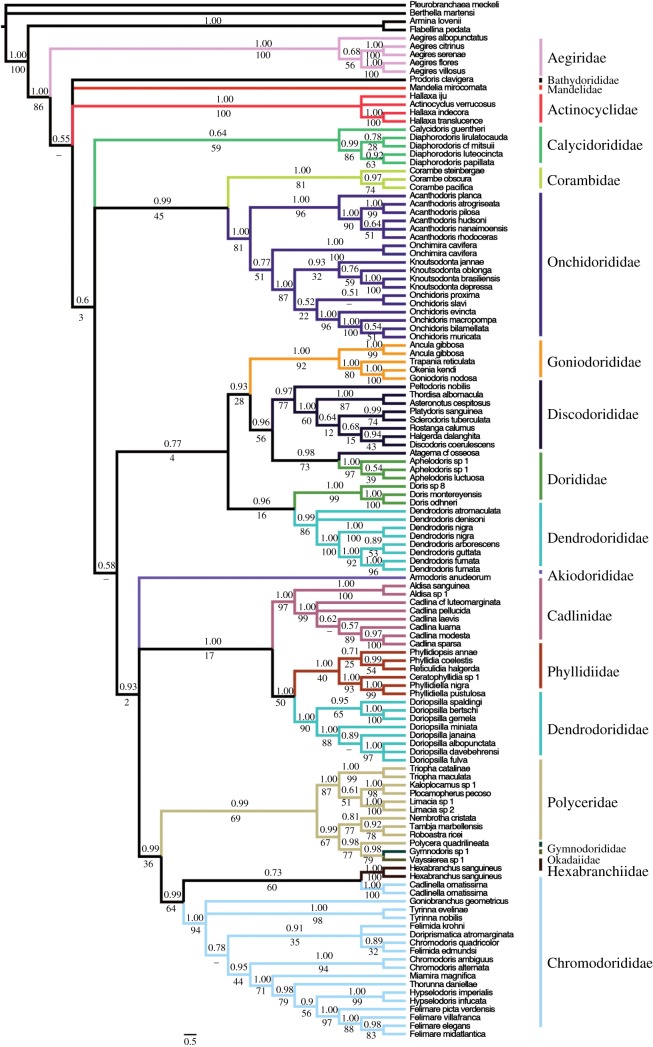
Phylogenetic estimate from Gblocks alignment. Topology represents Bayesian estimate, with posterior probabilities (pp) and non-parametric bootstrap (bs) support values depicted above and below each branch, respectively. Relationships that were not recovered by ML analysis are represented by dashes. Branches are coloured based on family designations and represented on the exterior of the phylogeny.